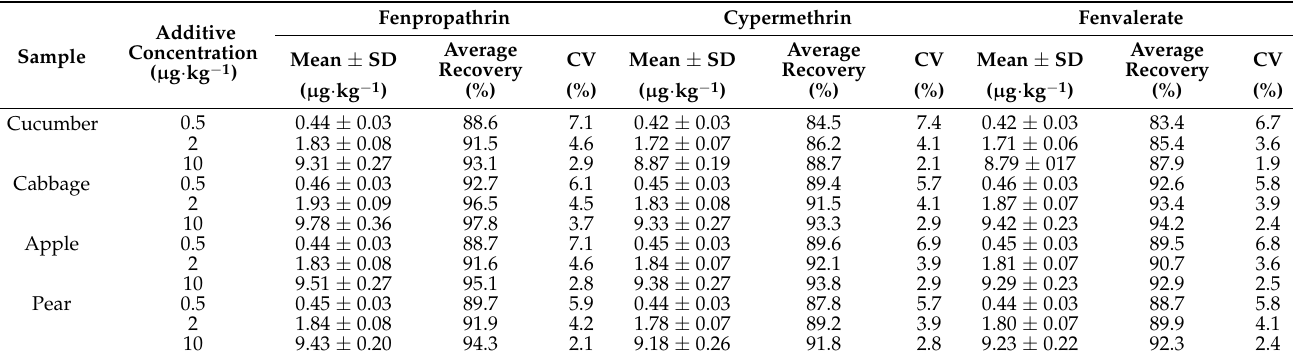
Table 1. Recovery rate of pyrethroids in added samples.